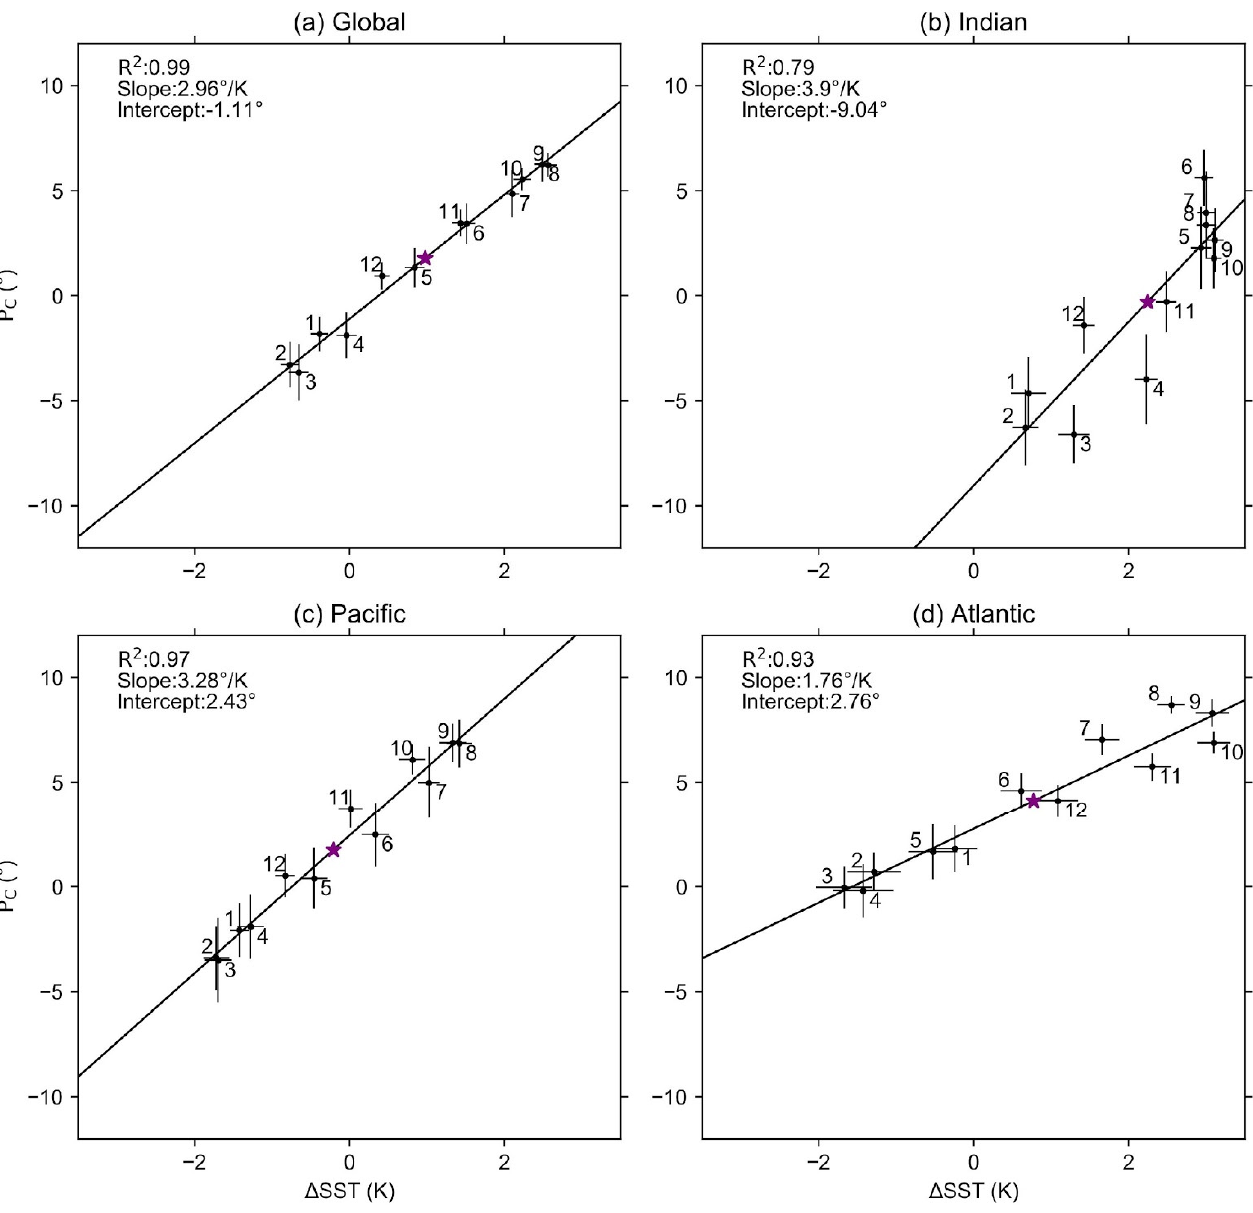
Figure 1. Observed seasonal cycle of the ITCZ position and interhemispheric SST contrast within each ocean basin. The 12 crosses represent the 21-year mean precipitation centroid and SST contrast for each month of the year. The length of each cross equals 1 standard deviation from the mean. The star is the annual average. Note the strong correlation in each basin, as well as the differences in the sensitivity of the ITCZ position to the local SST contrast.